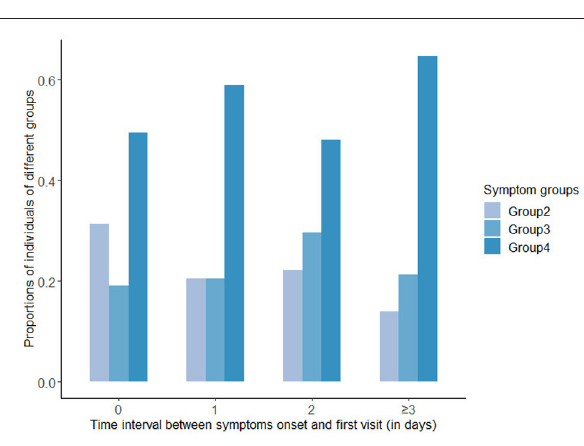
FIGURE 4 | Time intervals between symptoms onset and the first visit in different age